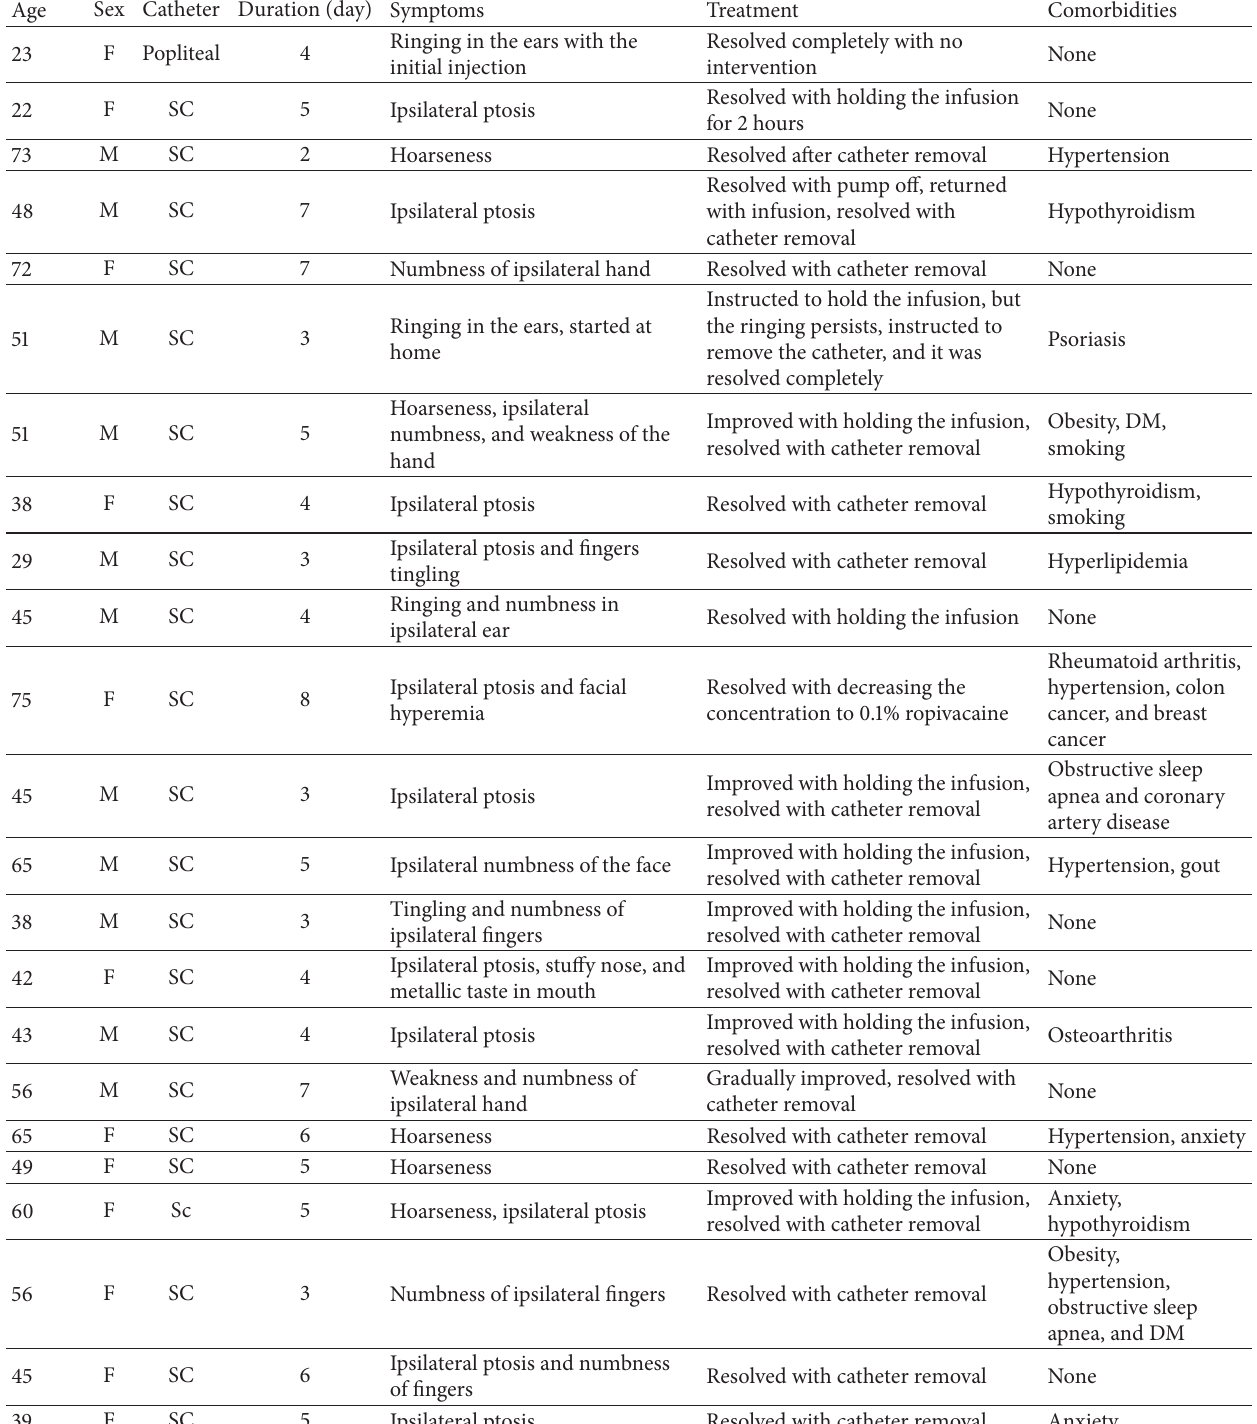
Table 3: Pharmacological